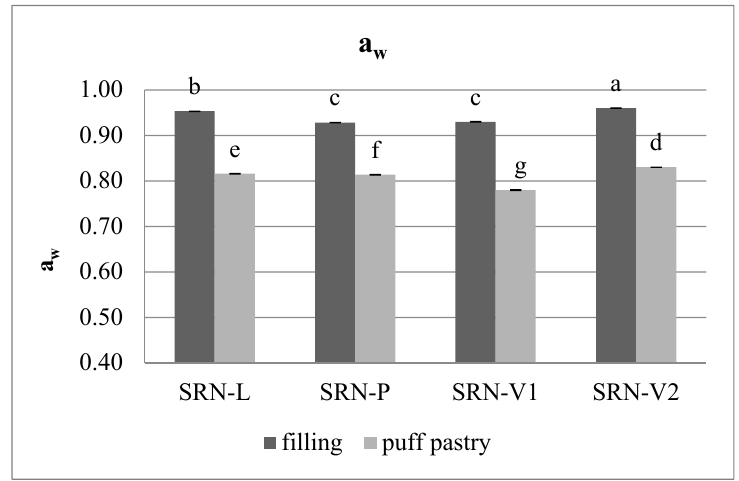
Figure 4. The a w values of the filling and puff pastry in baked SRNs produced with the different fat blends L, P, V1, and V2. a–g: Different letters indicate statistically significant differences ( p ≤ 0.05).